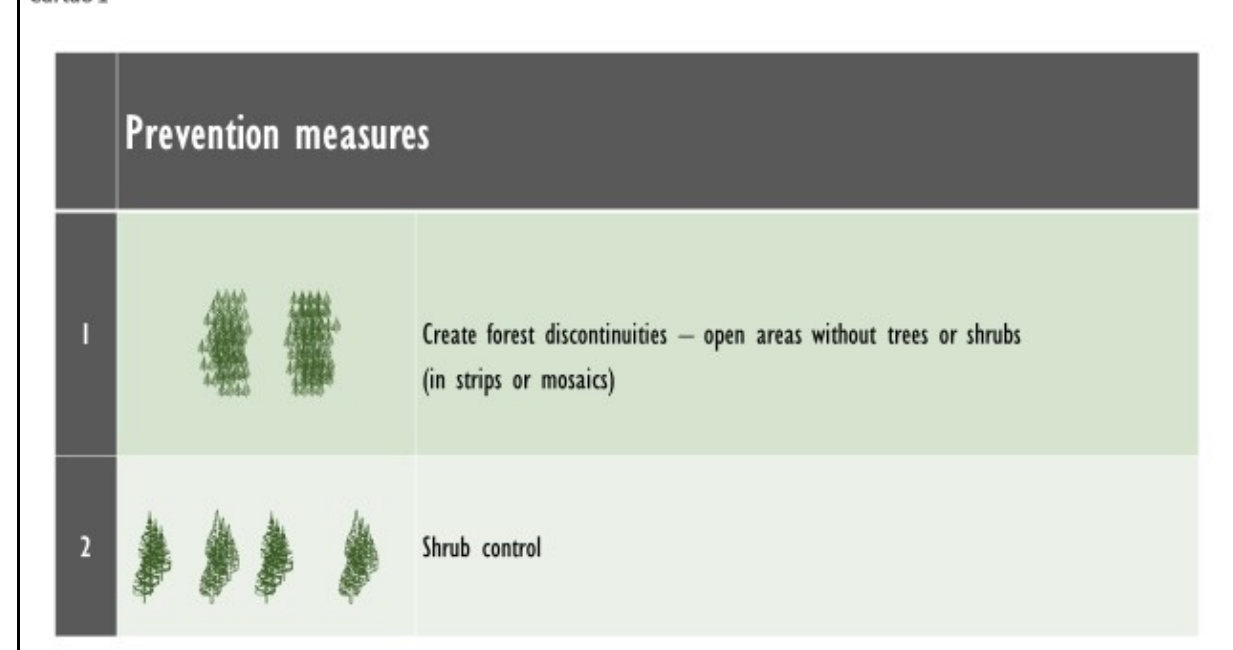
Figure A1. Card 1—Visual presentation of the commitments to be subscribed by the respondent for at least ten years and possible costs, for each commitment. The choice experiment only proceeded after careful presentation of each attribute and all doubts explained.